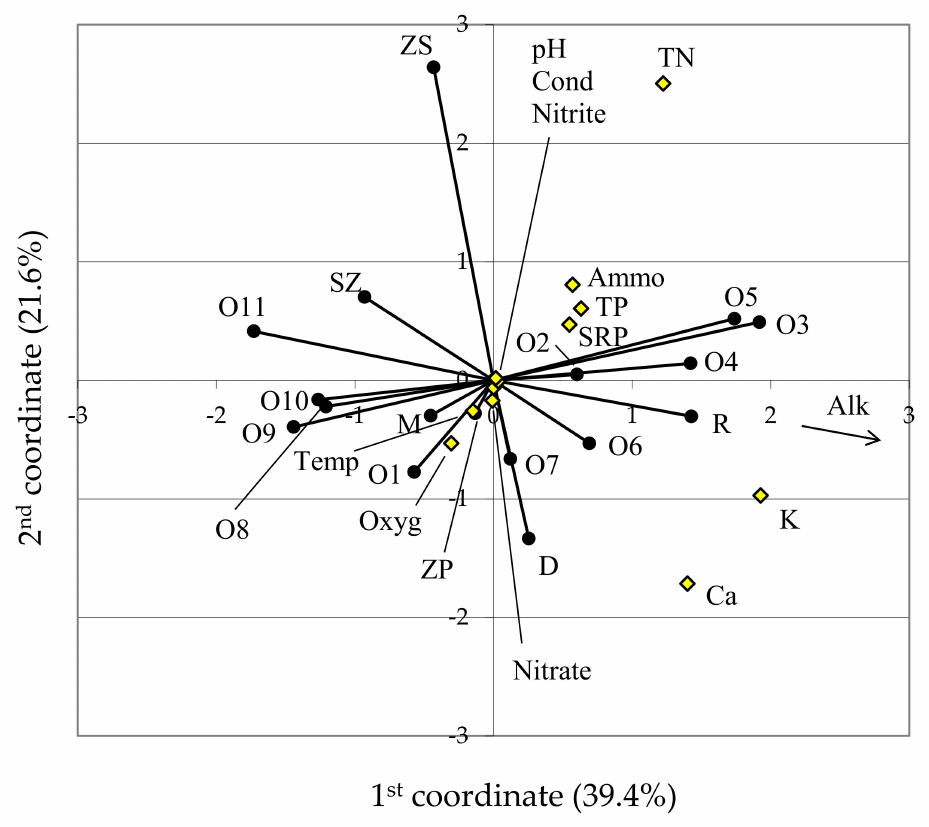
Figure 7. Position of monitoring sites determined by physicochemical parameters in the space of the first two canonical varieties and spacing of these parameters in the dual space (trait coordinates rescaled and multiplied by